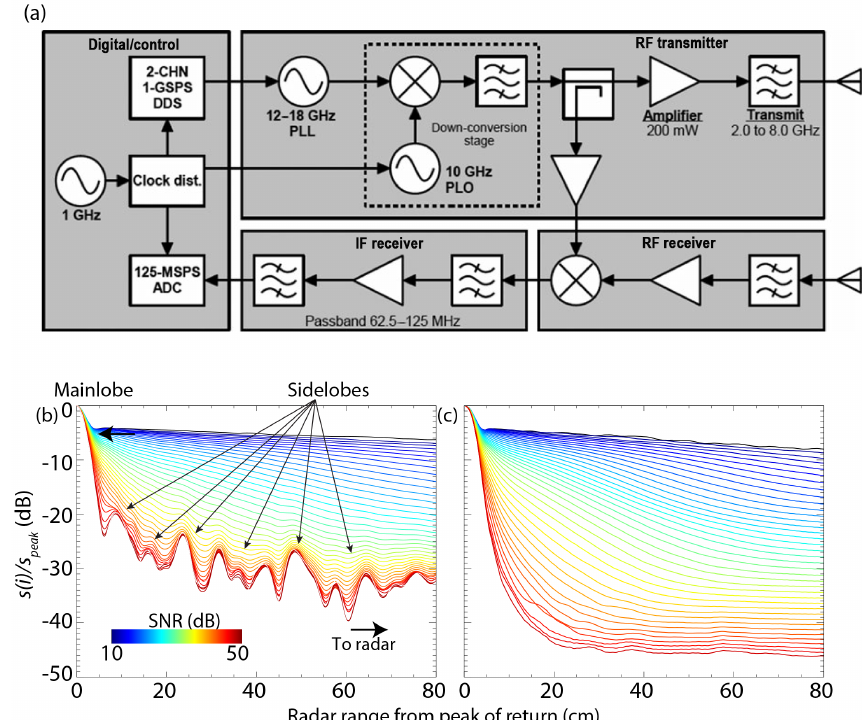
Figure 1. (a) Snow-radar hardware block diagram. Strength and location of sidelobes in the system impulse response (b) before and (c) after deconvolution of the radar data acquired during 2012 OIB Arctic campaign. Family of curves shows dependence on peak-signal-to-noise ratio (PSNR in dB) and is constructed using all the radar echoes ( ∼ 4 × 10 6 ) from the campaign. Normalized returns are for every 1dB increment of PSNR between 10 and